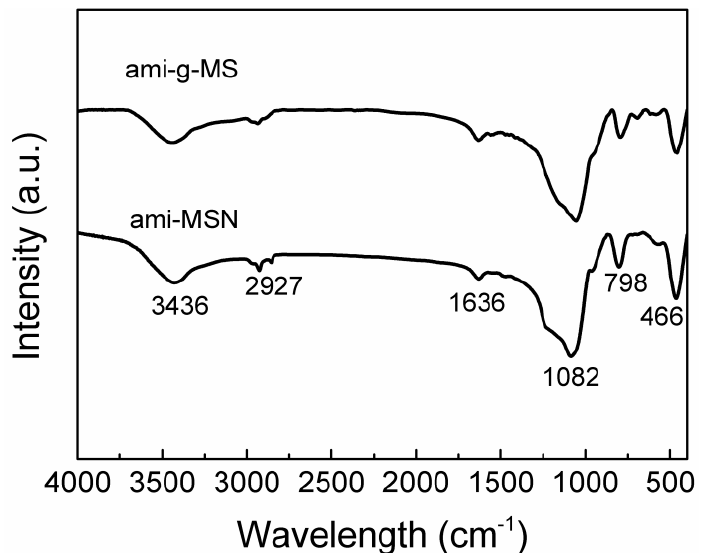
Figure 2. FT-IR spectra of ami-g-MS and ami-MSN.